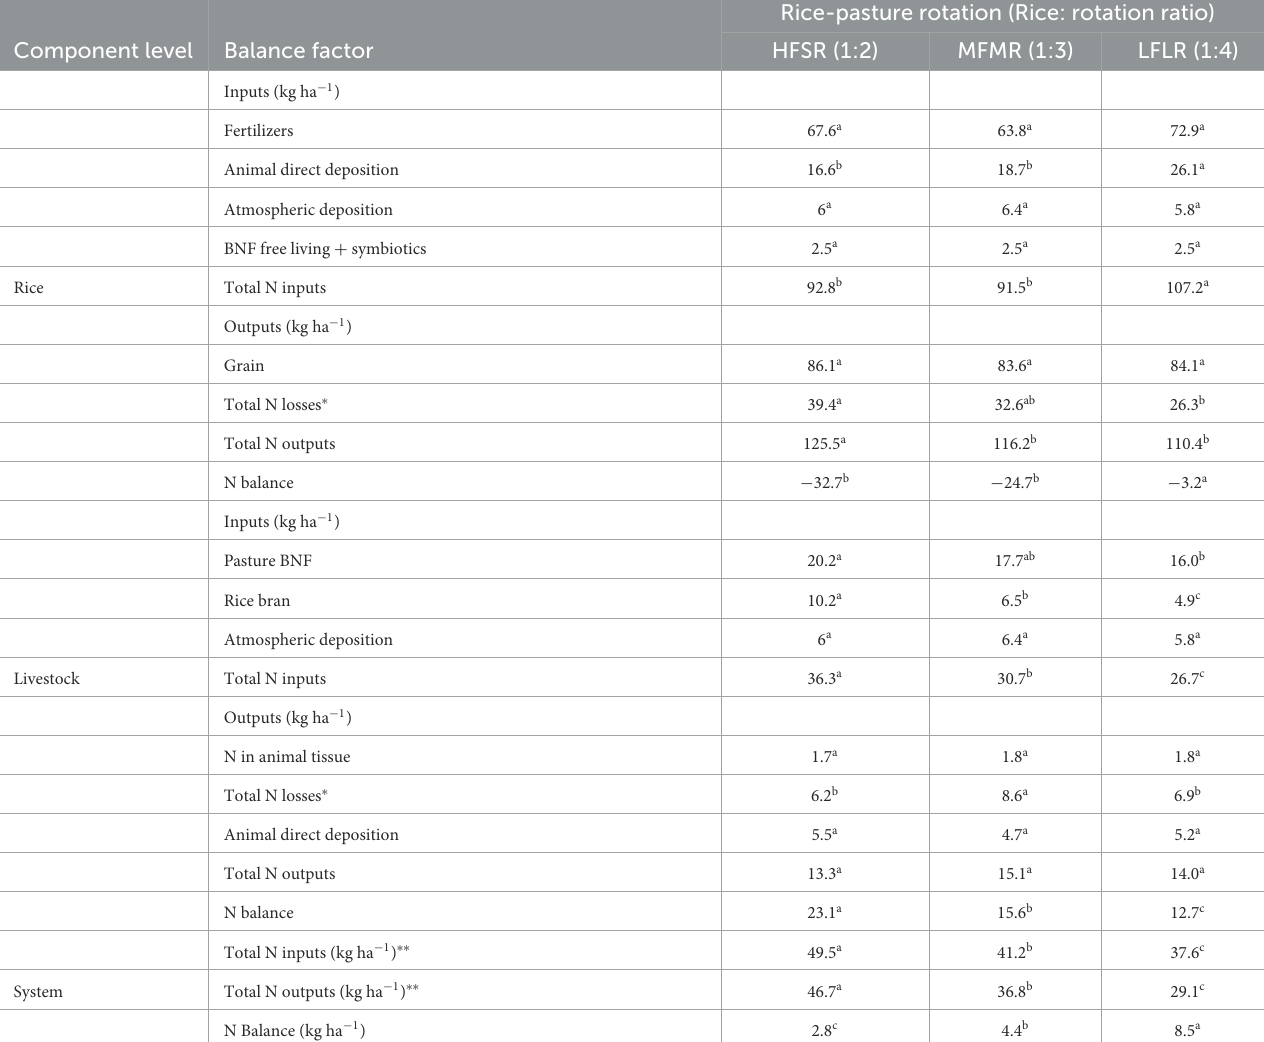
Rice-pasture rotation (Rice: rotation ratio)